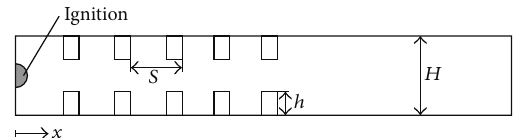
Figure 4: Schematic sketch of the channel geometry (side